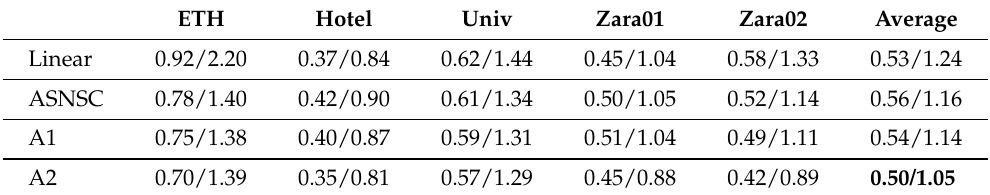
Table 4. ADE/FDE scores for each evaluation dataset using the leave-one-out strategy.